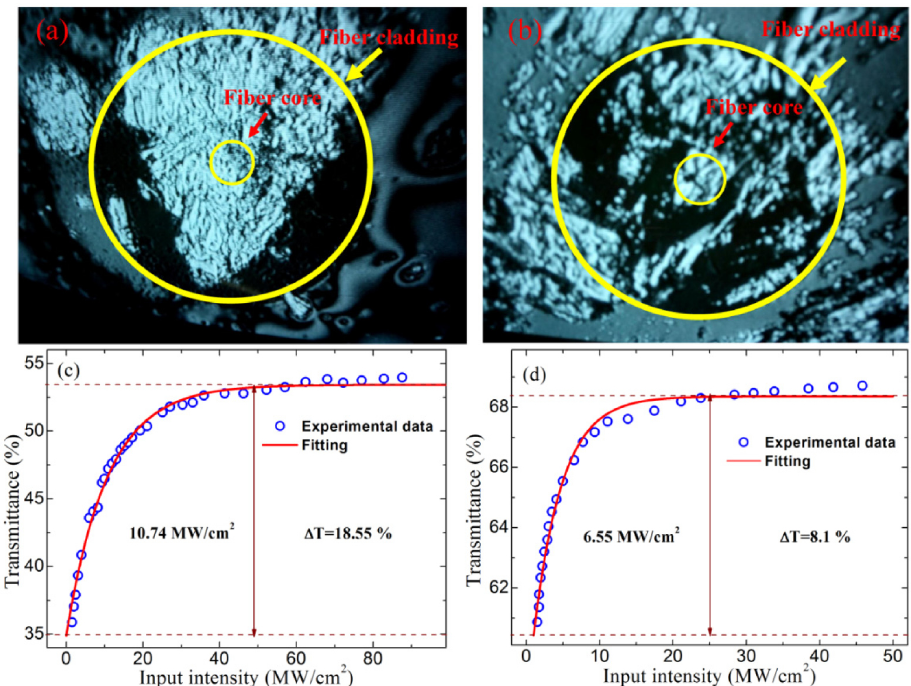
Figure 12. Optical image of the fiber end-facet (fiber cladding diameter of 125 µ m, fiber core diameter of 9 µ m) covered with relatively thick ( a ) and thin ( b ) BP and the measured saturable absorption data and its corresponding fitting curve of relatively thick ( c ) and thin ( d ) BP. Reproduced from ref. [32]. Optical Society of America, 2015.